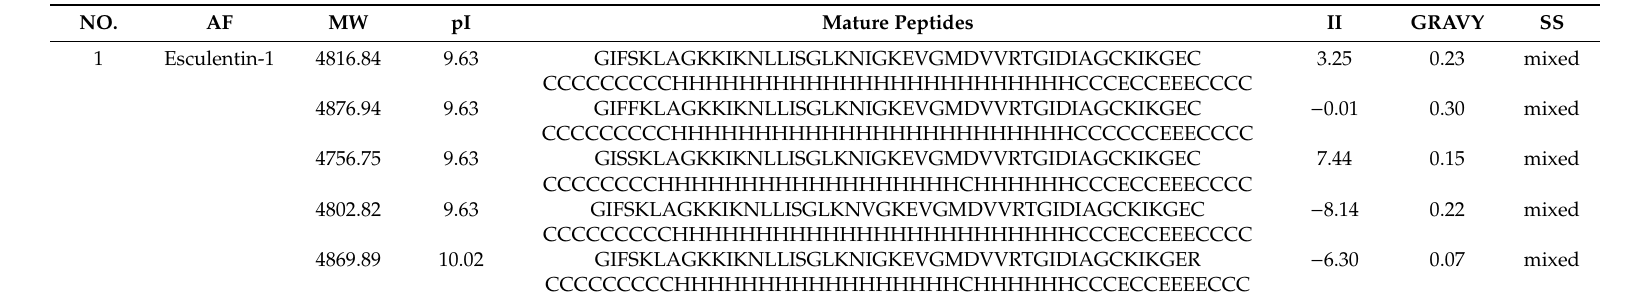
Table A3. The physicochemical and structural properties of mature peptides from P. nigromaculatus